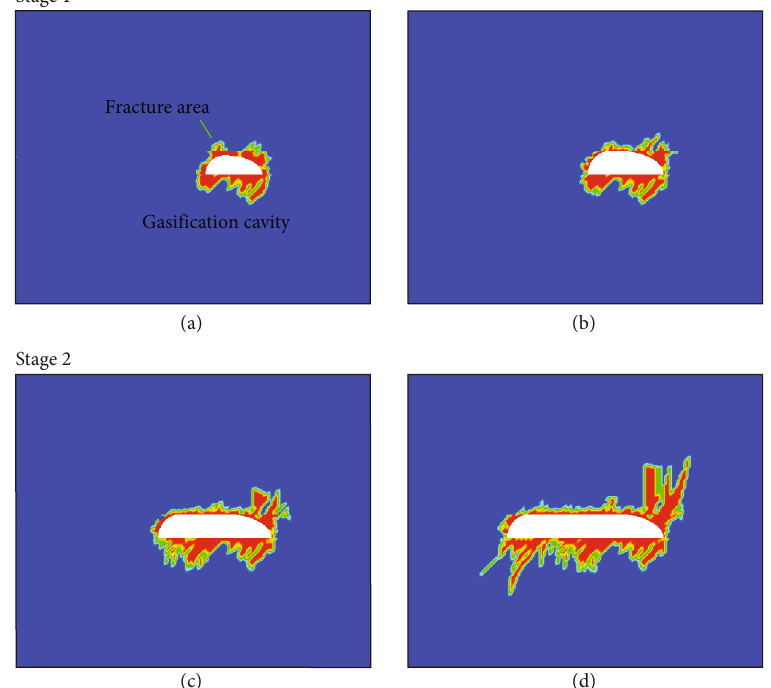
Figure 11: The evolution law of the failure characteristics around the surrounding rock of the combustion